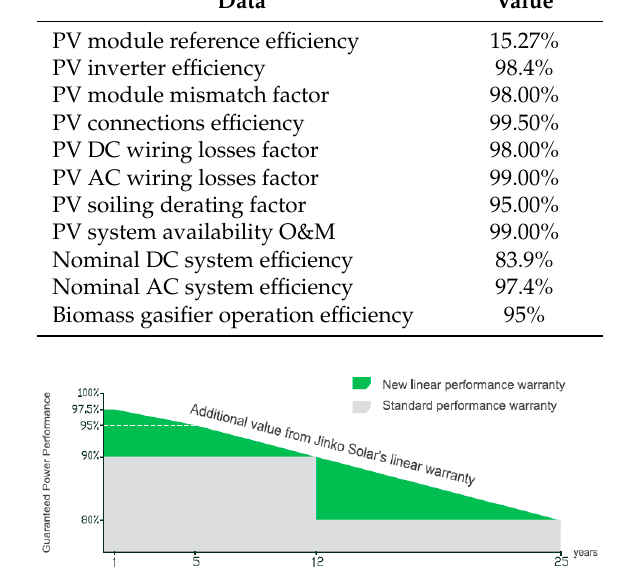
Figure 3. Premium performance warranty [8].